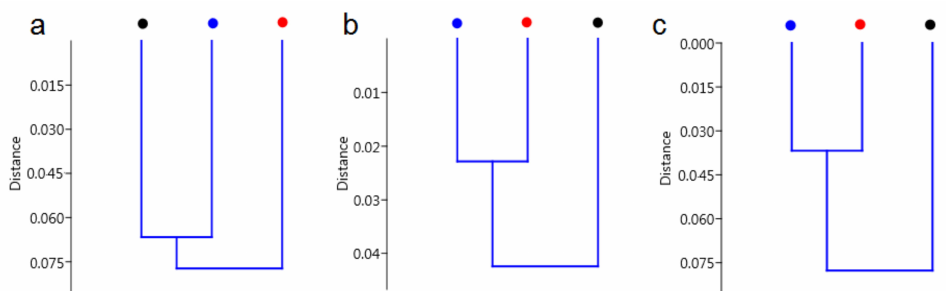
Figure 5. Hierarchical Clustering Analysis (HCA) analysis for selected IR region ( a ) (800 cm − 1 –